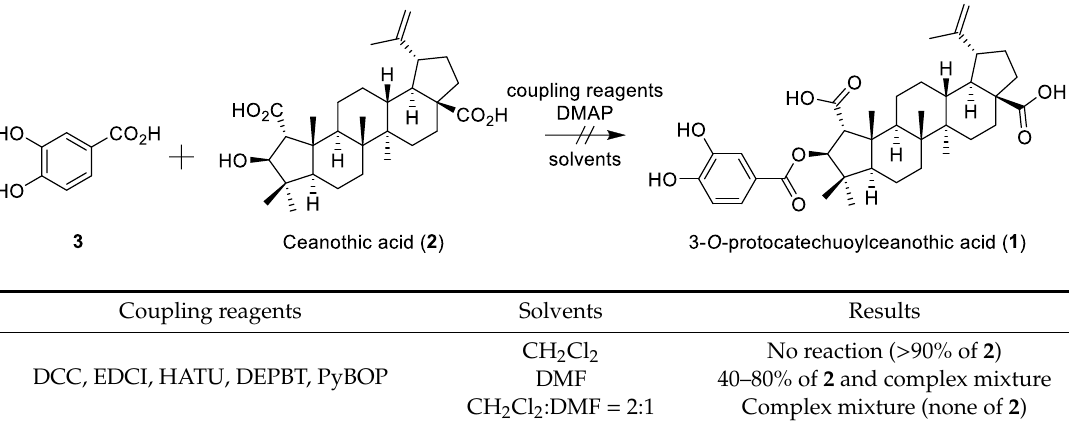
Figure 2. ( a ) GPR120 agonist activity of 25 triterpenoids isolated from Ziziphus jujuba. ([Ca ² + ]i in hGPR120-CHO cells); ( b ) Comparison of GPR120 agonist activity between hGPR120-CHO cells and Gα16 -CHO cells ([Ca ² + ]i in hGPR120-CHO cells and [Ca ² + ]i in Gα16 -CHO cells). The statistical difference between each group was analyzed using a S tudent’s t -test (* p < 0.05, ** p < 0.001, compared with hGPR120-CHO cells); ( c ) Structures of 3- O -protocatechuoylceanothic acid ( 1 ) and ceanothic acid